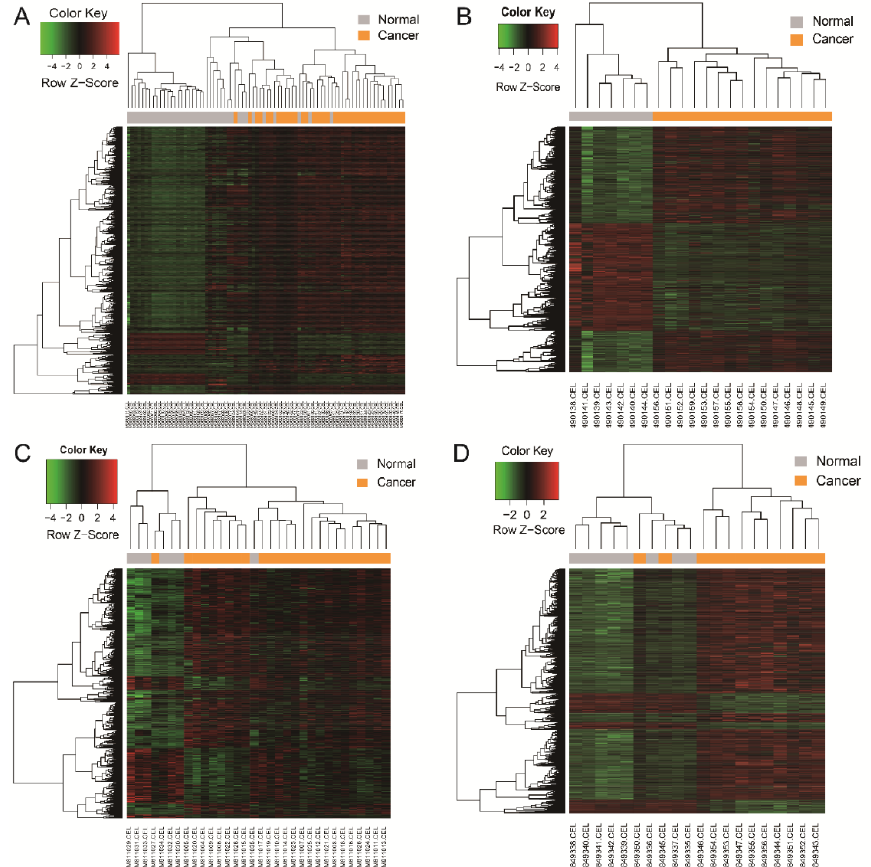
Figure 2. Heat map showing up-regulated and down-regulated di ff erentially expressed genes in pancreatic adenocarcinoma compared to the normal samples in the four datasets. The expression values are log2 transformed for absolute value of fold changes ( > 1 or < − 1) between normal tissues and pancreatic adenocarcinoma samples. Green represents down-regulation and red represents up-regulation. ( A ) GSE15471; ( B ) GSE19650; ( C ) GSE32676; ( D )